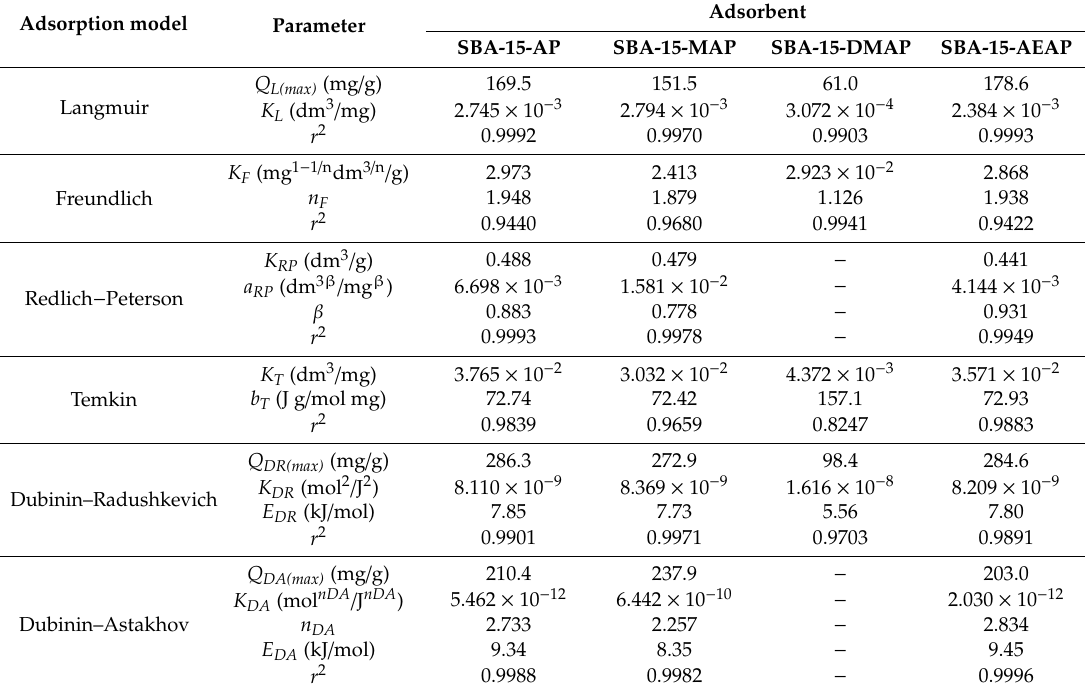
Table 3. Isotherm parameters calculated from linear regression for 18 β -glycyrrhetinic acid adsorption onto mesoporous silica functionalized with various amine